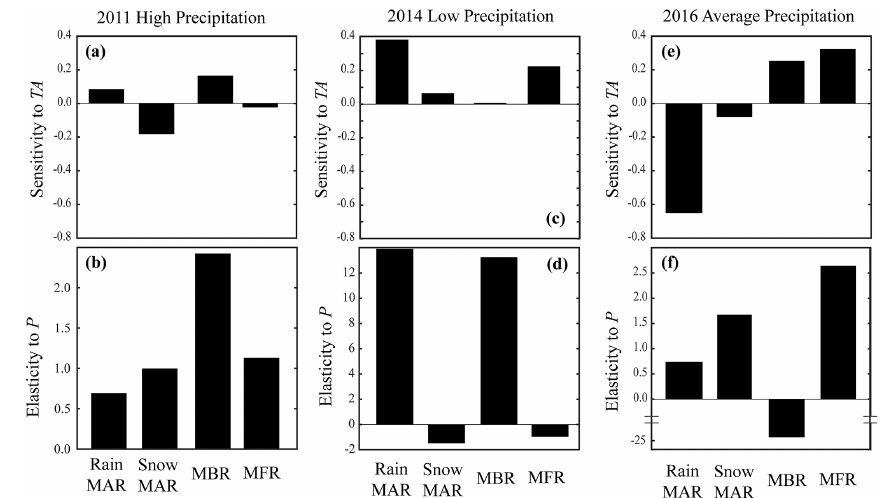
Figure 8. Sensitivity to T air and elasticity to P of different mountain system recharge pathways for WY2011 (a, b) , WY2014 (c, d) , and WY2016 (e, f) . Each bar represents the mean value for the scenarios in the ConstPVarTA (a, c, e) and VarPConstTA (b, d, f) experiments in the Kaweah Terminus